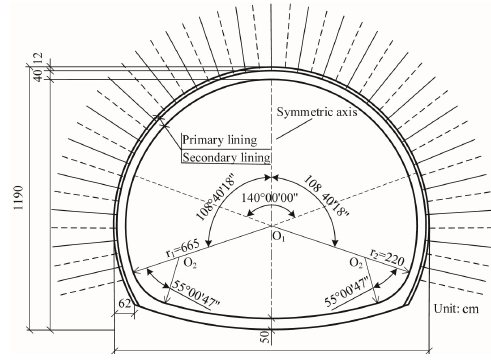
Figure 6. Geometric details of the tunnel lining. Table 1. Material parameters of the concrete lining.